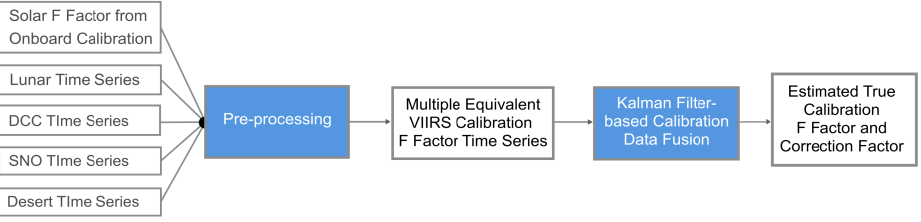
Figure 2. Framework of Kalman-Filter-based Calibration Data Fusion (KFCDF) system for VIIRS (Reflective Solar Bands (RSBs) with wavelength < 1 µm).